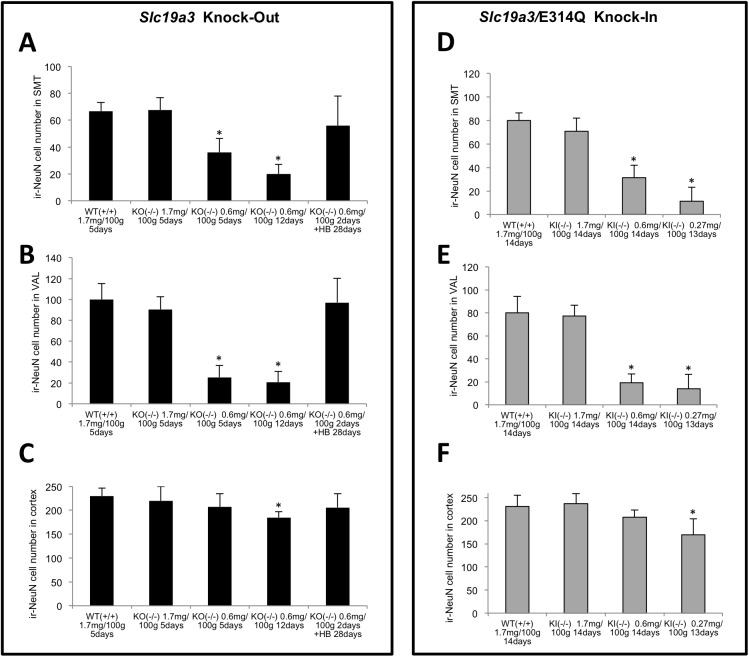
Numbers of NeuN-immunoreactive neurons in the thalamic area and cortex of WT, homozygous Slc19a3 KO and KI mice.The numbers of NeuN-immunoreactive neurons of homozygous KO (A) and KI (D) mice in the submedial nucleus of the thalamus (SMT) (0.13 mm2); homozygous KO (B) and KI (E) mice in the ventral anterior-lateral complex of the thalamus (VAL) (0.2 mm2); and homozygous KO (C) and KI (F) mice in the cortex (0.2 mm2). Mean numbers of three experiments are shown. One-way ANOVA, two-way ANOVA, and the Steel–Dwass test were used for statistical comparisons. Asterisks (*) indicate that the numbers of NeuN-immunoreactive neurons of KO and KI mice fed with thiamine-restricted diets were significantly different from those of WT mice (first bar of each graph) at p < 0.05.